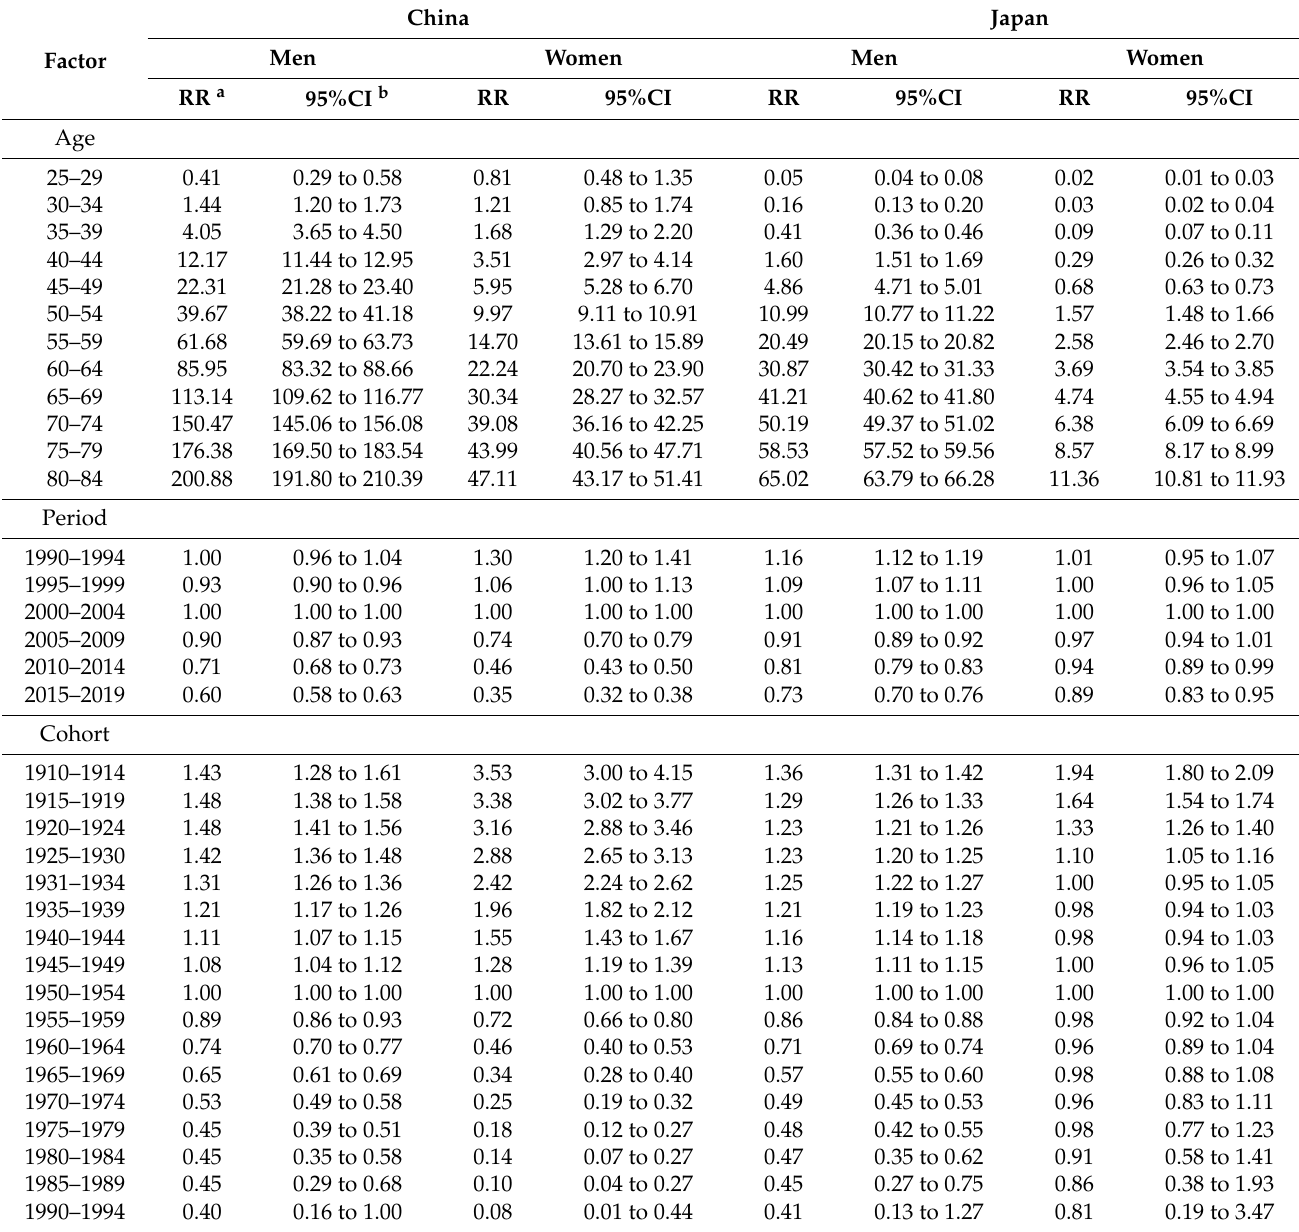
Table 3. The relative risks due to age, period, and cohort effects in China and